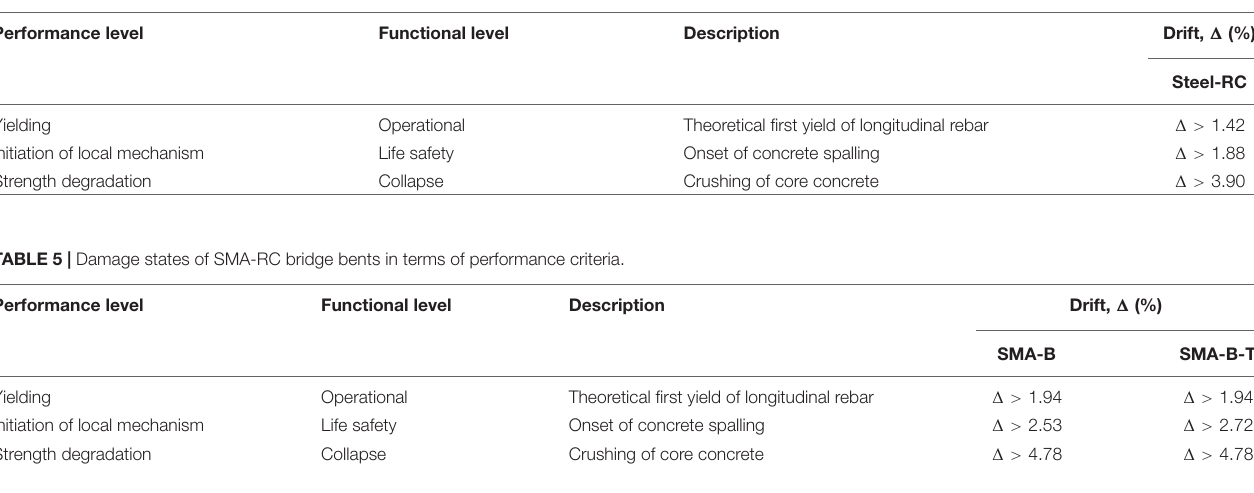
TABLE 4 | Damage states of steel-RC bridge bents in terms of performance criteria.